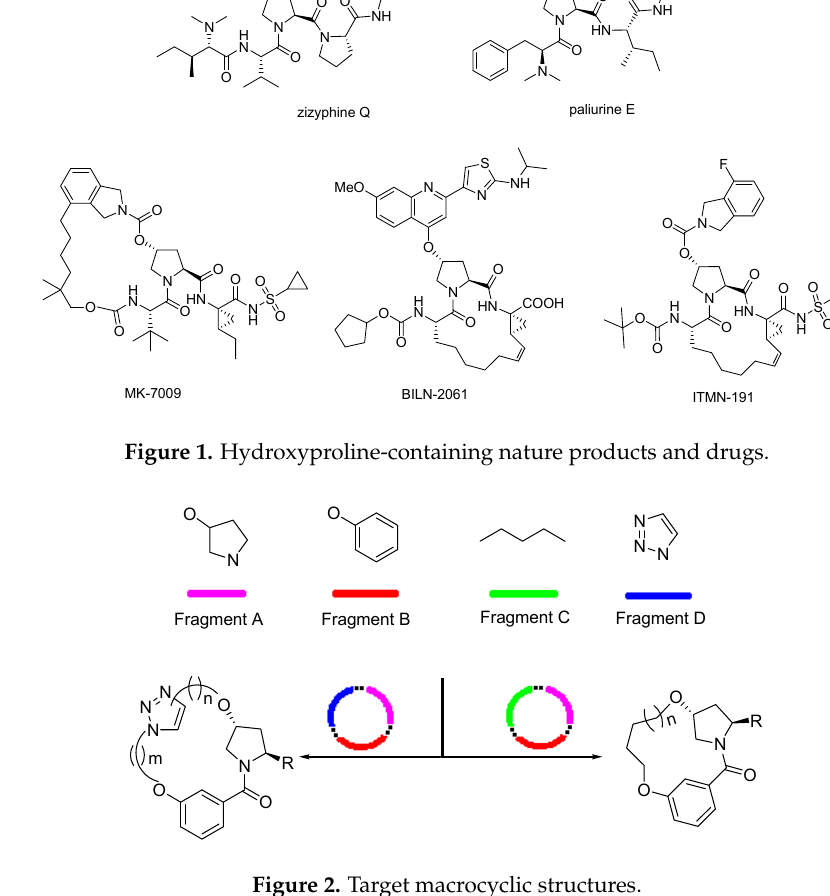
Figure 2. Target macrocyclic structures.